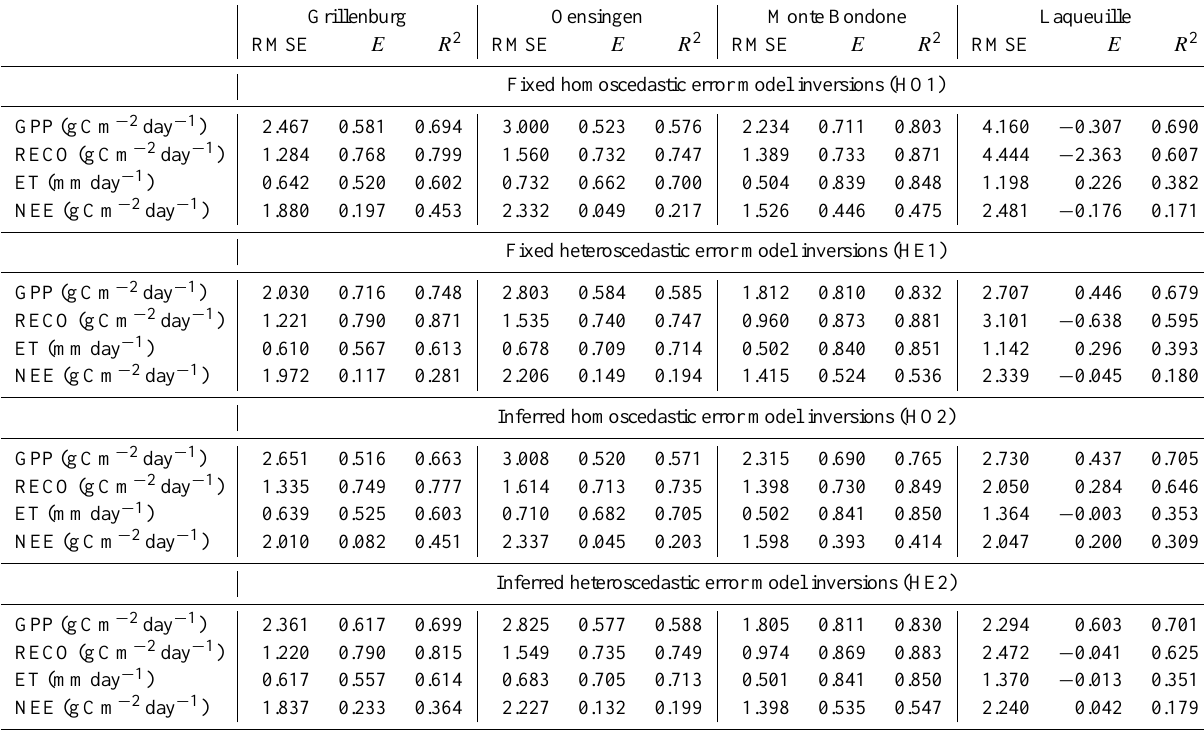
Table 6. Validation of the calibrated model using most likely parameter values from the inversions. Grillenburg Oensingen Monte Bondone Laqueuille Fixed homoscedastic error model inversions (HO1)